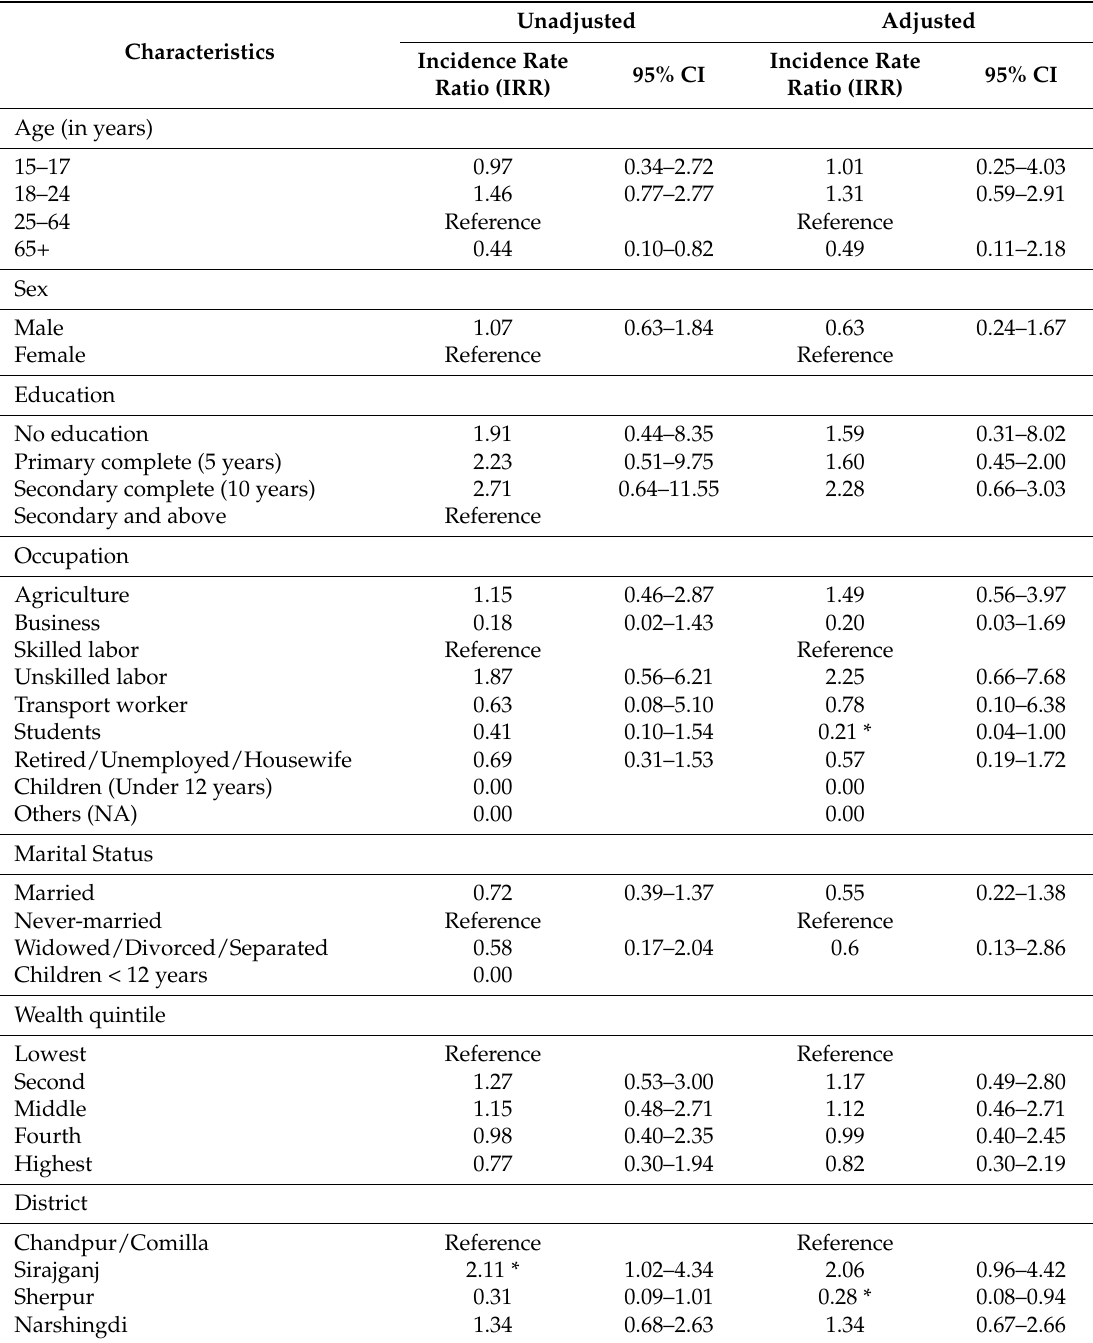
Table 5. Unadjusted and adjusted analysis of non-fatal suicidal behavior by socio-demographic and geographical factors, rural